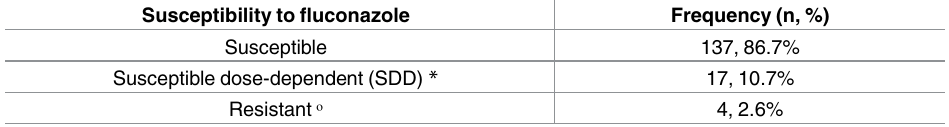
Table 2. Frequency of susceptibility to fluconazole (2012 CLSI